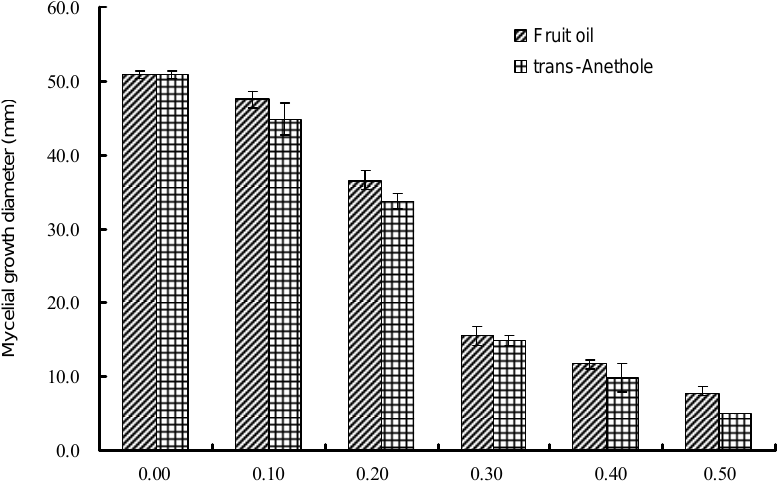
Figure 1. Effect of vapor components in I. verum fruit oil and trans -anethole on mycelial growth of P. aphanidermatum by vapor contact